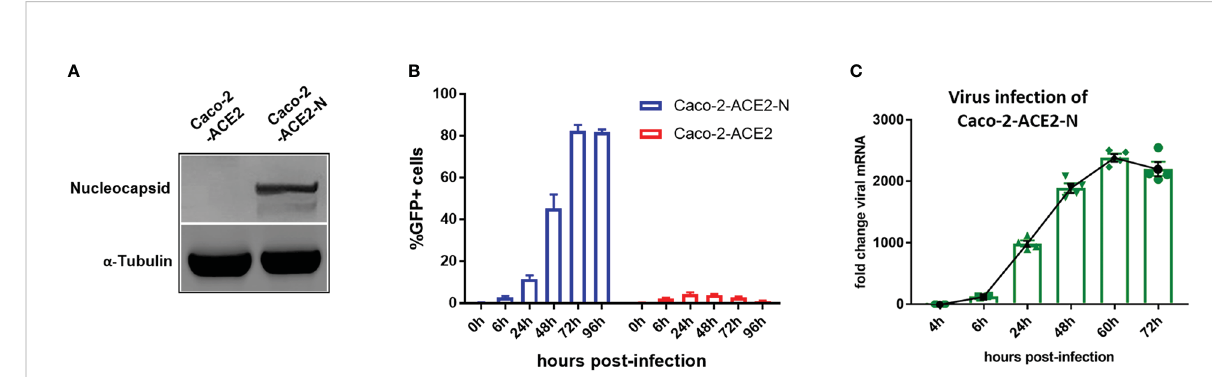
FIGURE 2 Establishment of pseudo-SARS-CoV-2 infection system in epithelial cell lines mimicking viral life cycle. (A) Caco-2-ACE2 cells were stably transfected with nucleocapsid. Western blot showed overexpression of nucleocapsid in Caco-2-ACE2-N cells. (B) Caco-2-ACE2 or Caco-2- ACE2-N cells (2x10 5 ) were inoculated and infected with SARS-CoV-2 GFP/ D N trVLP. GFP+ cell percentage was quanti fi ed by fl ow cytometry at indicated time points. (C) Replication kinetics of SARS-CoV-2 GFP/ D N trVLP in Caco-2-ACE2-N cell was quanti fi ed with viral RNA expression by RT-PCR after